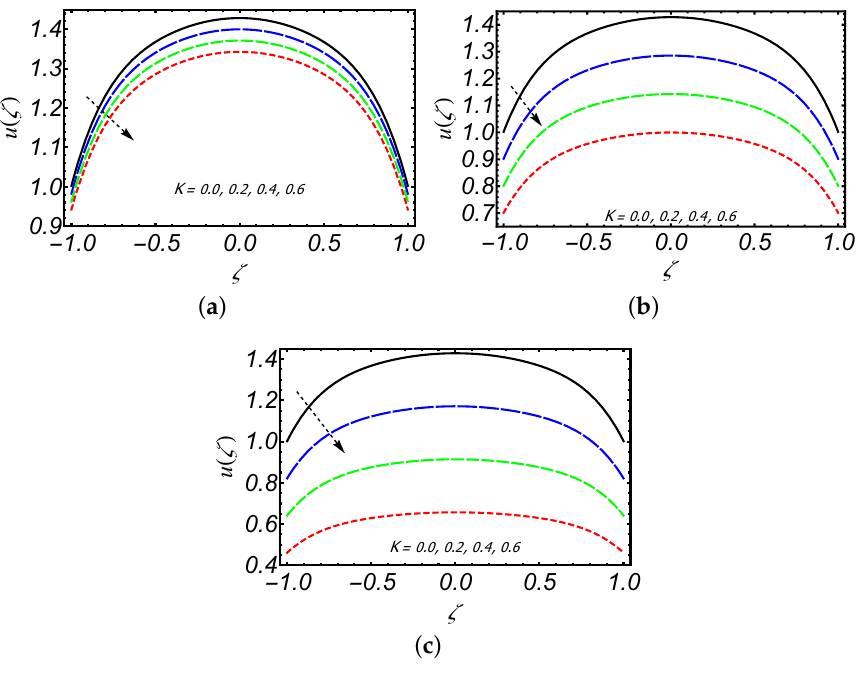
Figure 4. Behavior of u ( ζ ) with K at ( a ) x = 0.1, ( b ) x = 0.5, ( c ) x = 0.9, when φ = δ = 0.2.